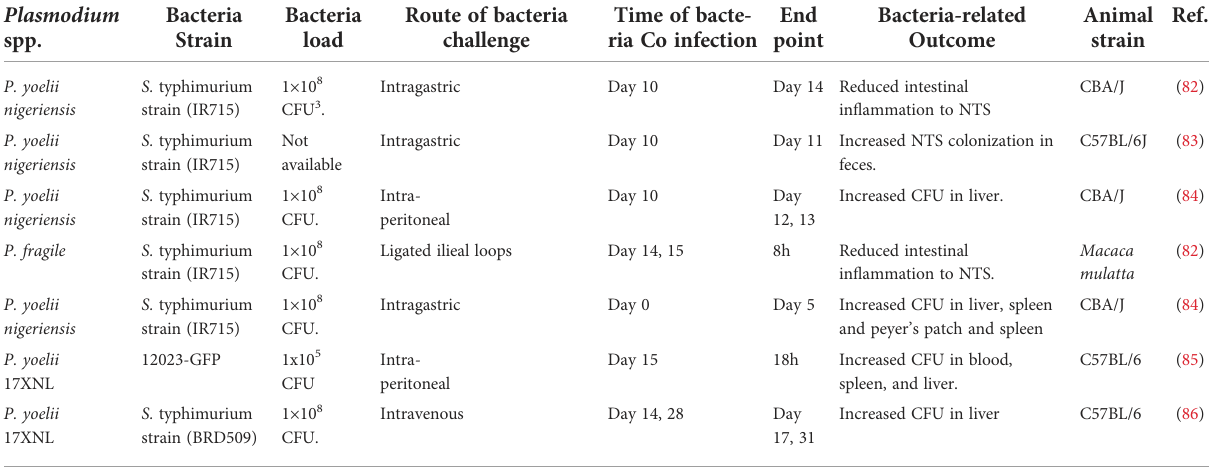
TABLE 2 Showing studies on malaria and salmonella co-infection. Plasmodium